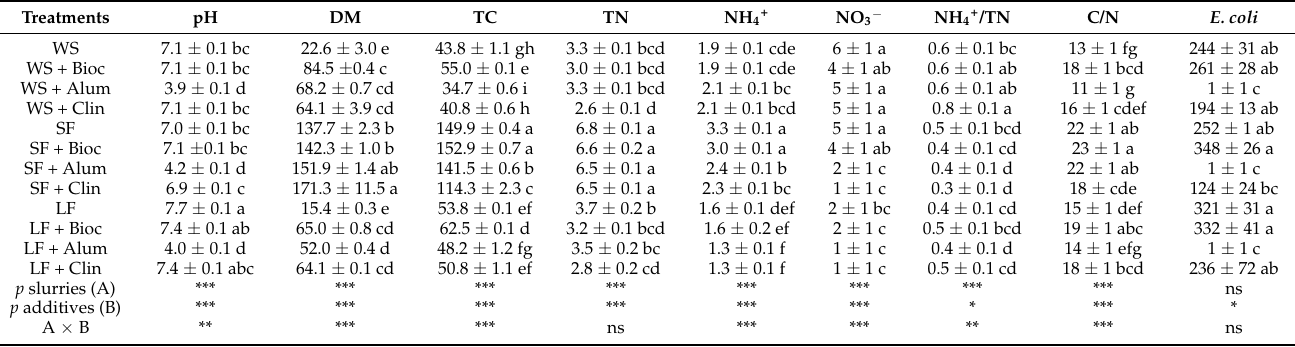
Table 1. Physicochemical and biological characteristics of the treatments at the beginning of the experiment (mean ± standard deviation) ( n =